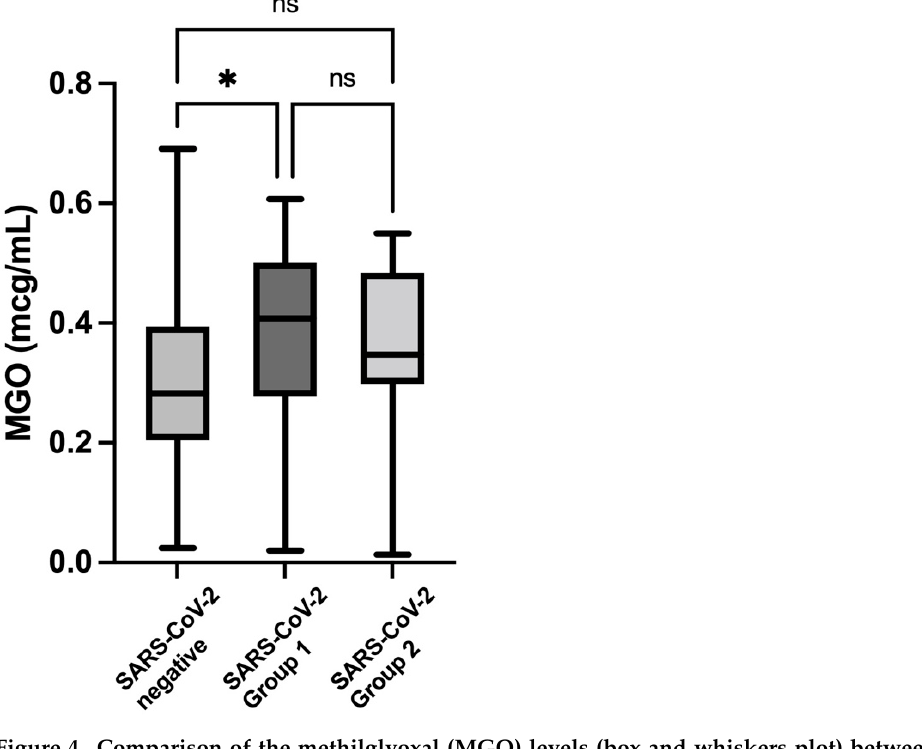
Figure 4. Comparison of the methilglyoxal (MGO) levels (box and whiskers plot) between the SARS-CoV-2 group 1 (0.41; IQR 0.28–0,50) and group 2 (0.35; IQR 0.29–0.48) subjects and the control subjects (for values, see Figure 2 ), with multiple post hoc comparisons. * p value < 0.05 . ns: non significant.